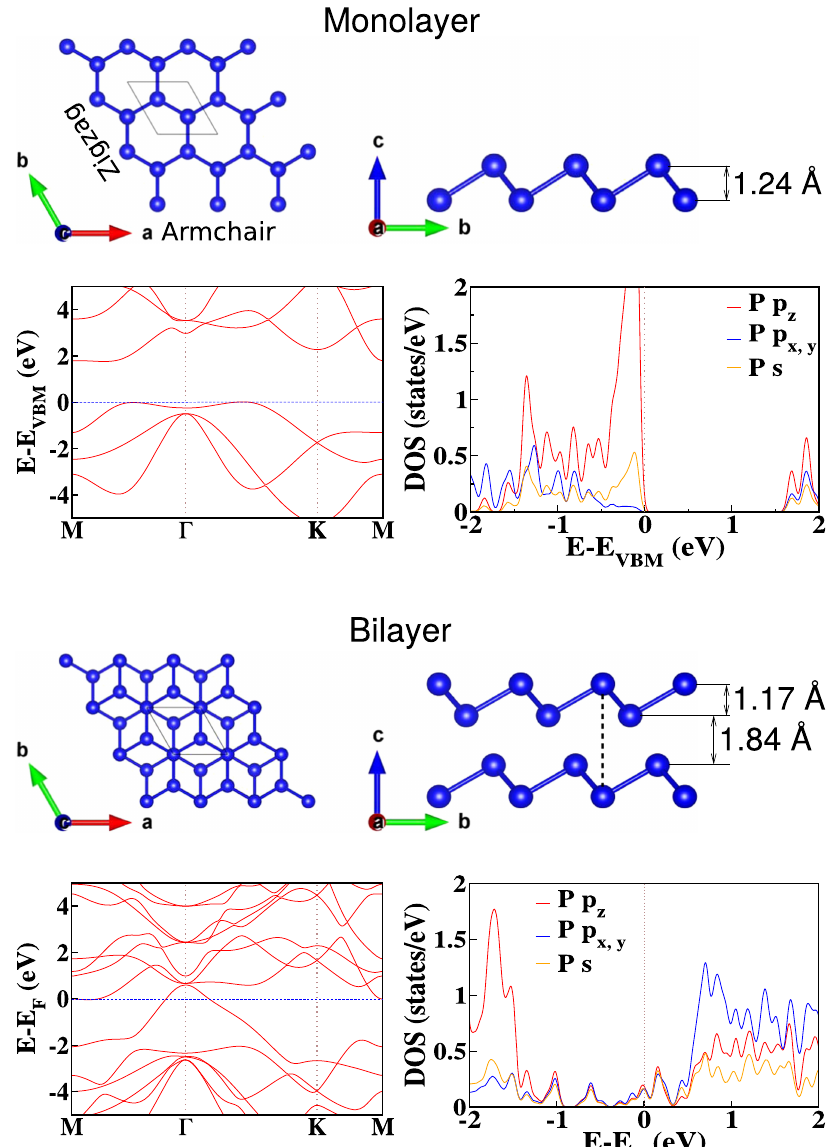
Fig. 1 Monolayer and bilayer blue phosphorene. Top view, side view, band structure (unit cell), and partial densities of states (unit cell) are